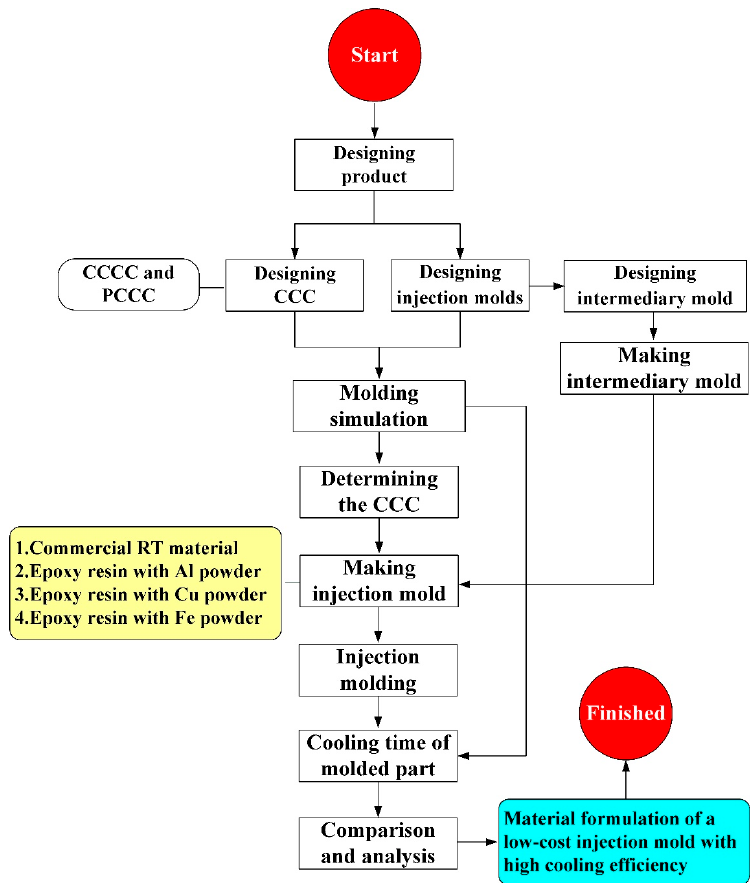
Polymers 2022 , 14 , x FOR PEER REVIEW Figure 1. The detailed steps of the research process of this study. Figure 1. The detailed steps of the research process of this study.